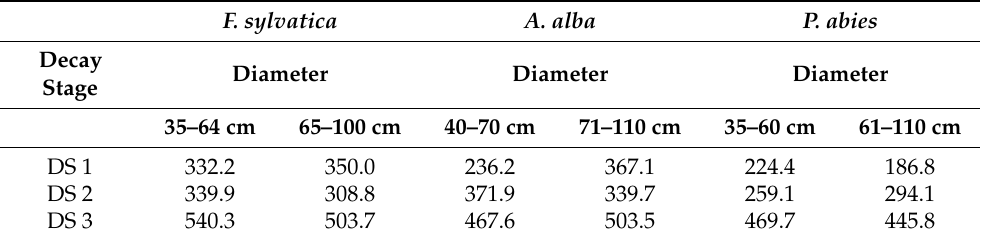
Table A1. Mean values of water content (kg.m − 3 ) depending on decay stage, species, and diameter of downed